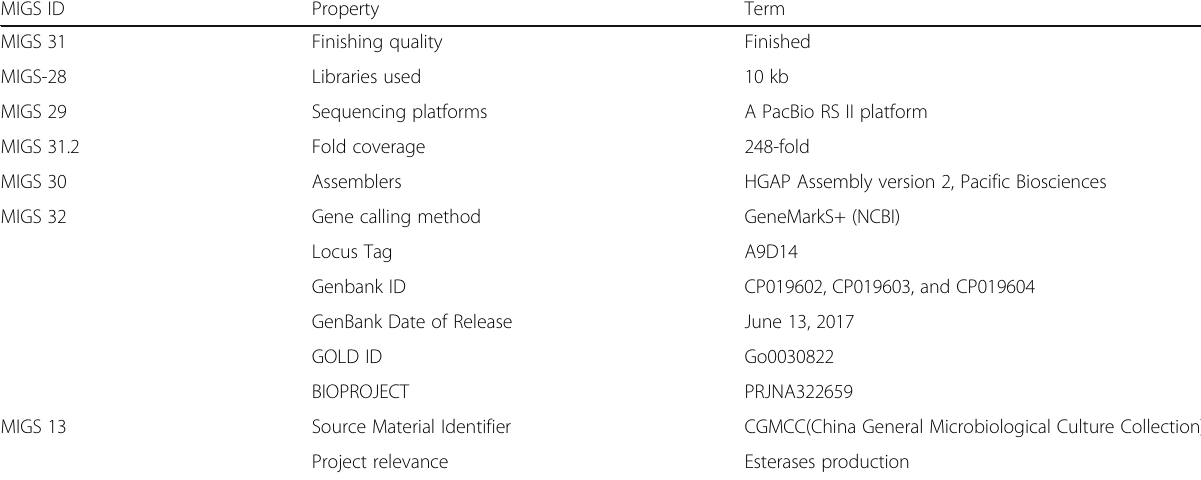
Table 2 Genome sequencing project